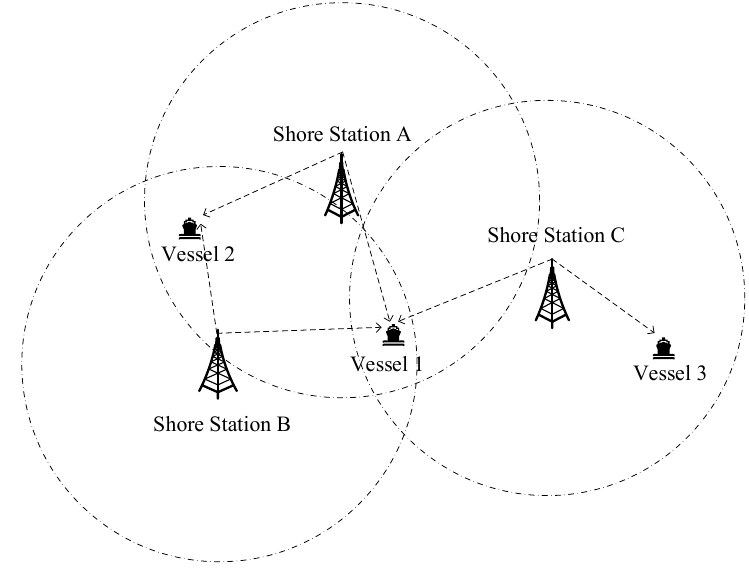
Figure 1. Coverage areas of automatic identification system (AIS) stations: different cases.